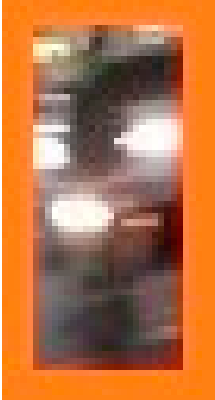
Figure 12. The blurry object from Figure 11.